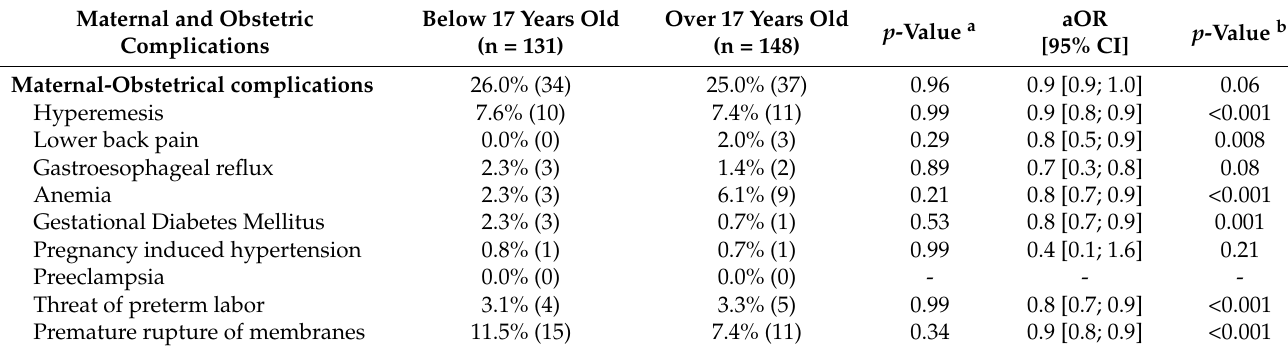
Table 2. Maternal-obstetrical complications during pregnancy according to maternal age.